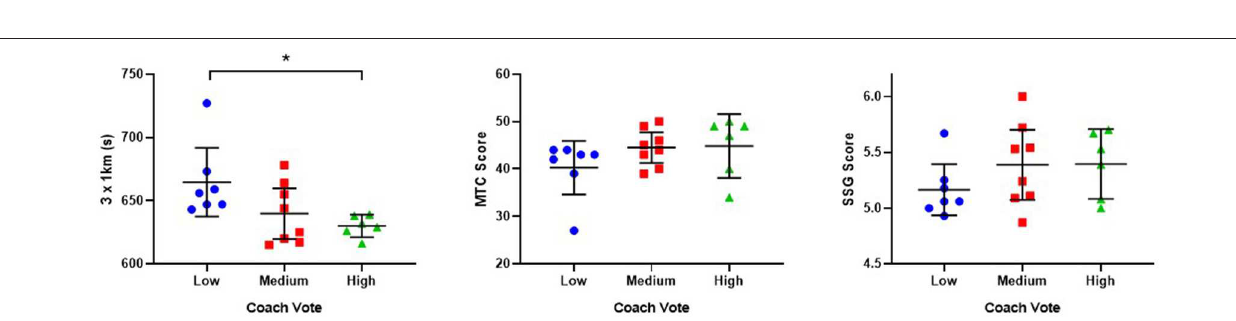
Frontiers in Sports and Active Living |